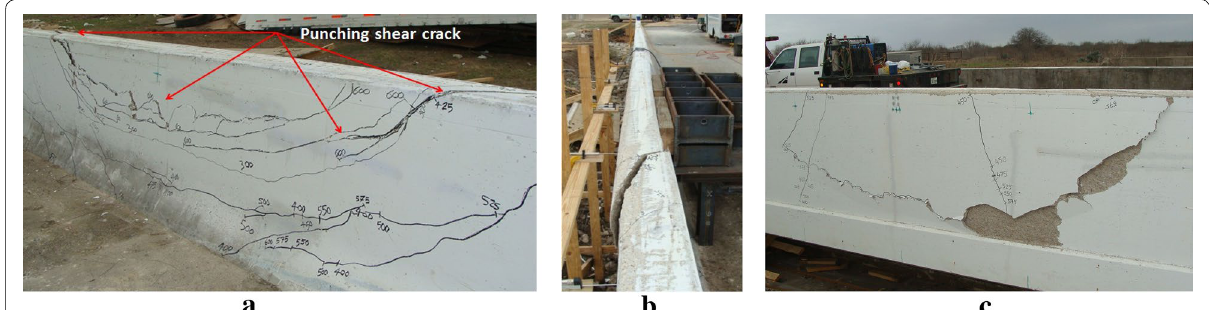
Fig. 13 Views of crack pattern of barrier segment loaded at mid-length between two control joints. a Crack pattern at front face of the barrier, b wall punching shear, c crack pattern at barrier back